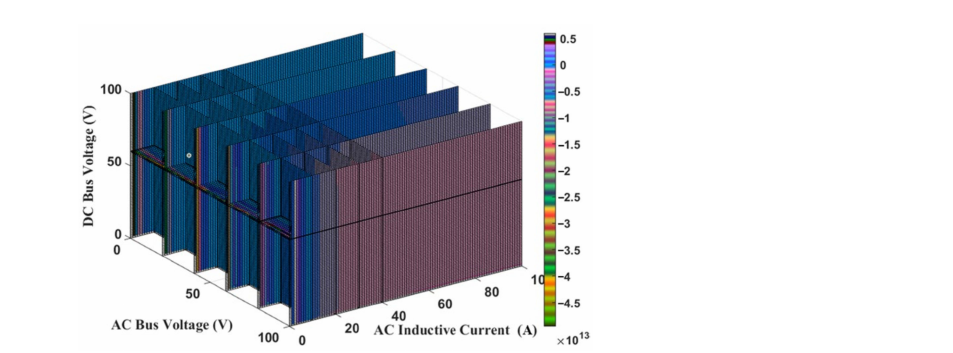
Figure 12. Four-dimensional graph of the first derivative of Lyapunov function with respect to time of microgrids with the battery in discharging mode.